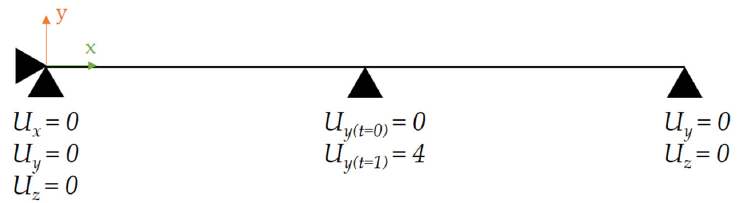
Figure 3. Finite element (FE) model with boundary conditions.